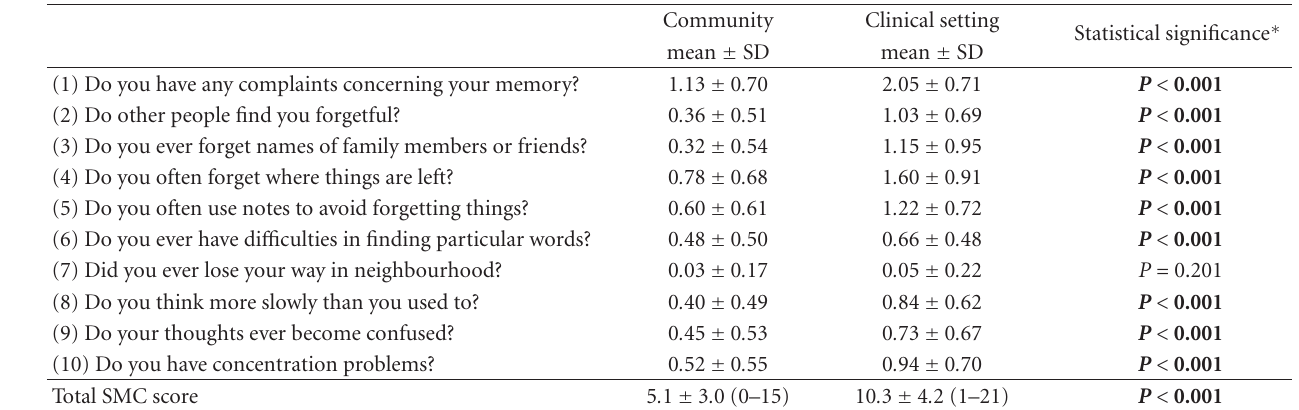
Table 2: Subjective memory